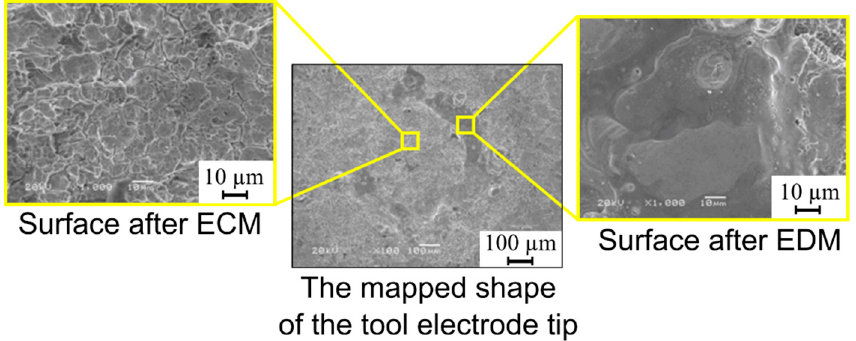
Figure 13. SEM images after the ECM test.